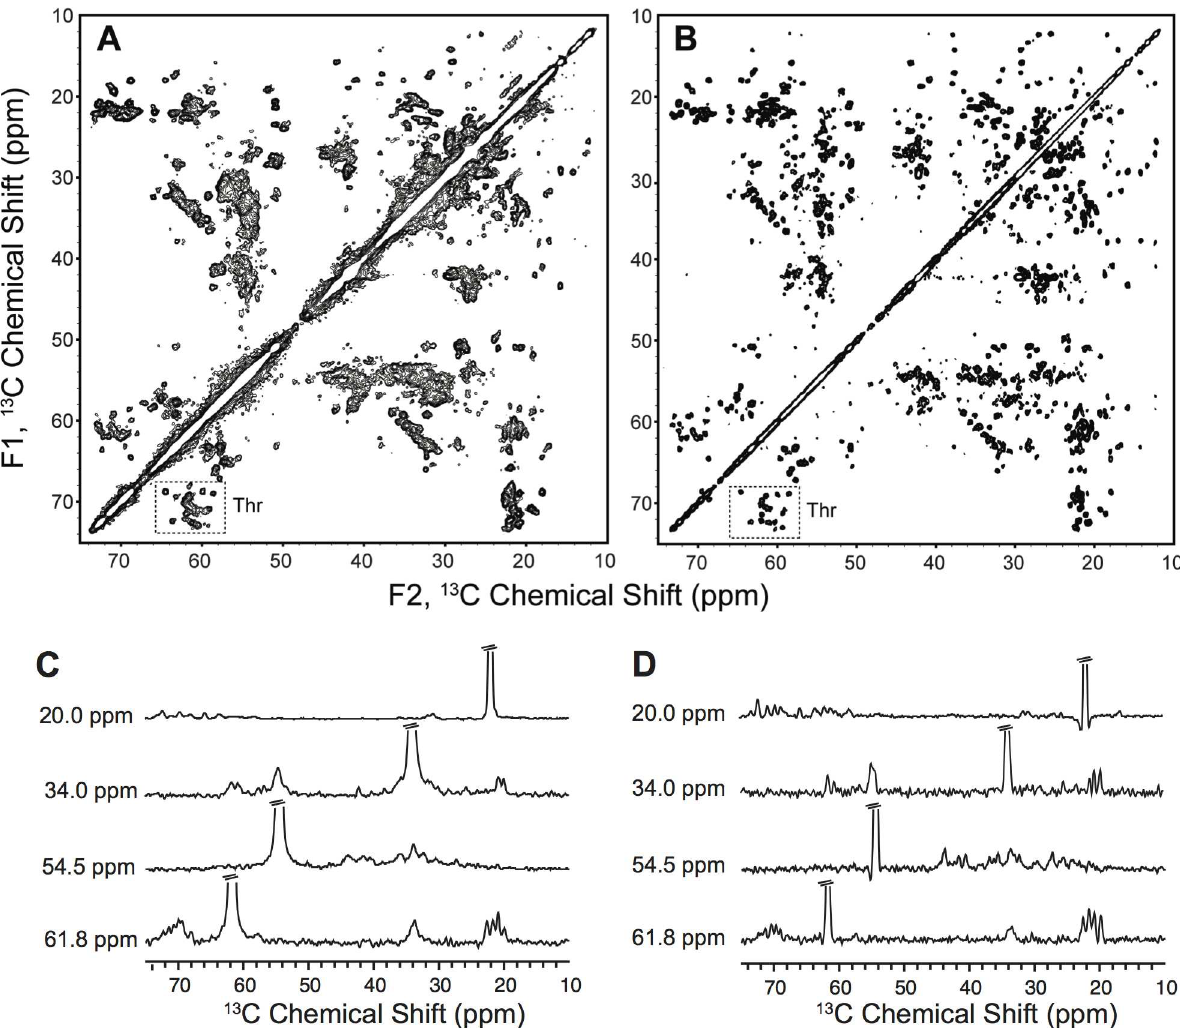
Fig 3. Solid-state 13 C- 13 C 2D correlation spectra of uniform 13 C, 15 N sTF. (A) 13 C- 13 C 2D correlationspectrum with 25 ms of DARR mixing of ~15 mg uniform 13 C, 15 N sTF precipitated with 15% PEG 3350 acquired at 750 MHz ( 1 H frequency) for 12 hours with a MAS rate of 12.5 kHz at a variable temperature set point of 0˚C. (B) 13 C- 13 C 2D correlationspectrum with 50 ms of DARR mixing of ~31 mg uniform 13 C, 15 N sTF precipitated with 1.8 M ammoniumsulfate and 5 mM Cu-EDTA acquired at 750 MHz ( 1 H frequency) for 24 hours with a MAS rate of 12.5 kHz at a variabletemperature set point of -5˚C. Both spectra were processedwith 20 Hz of Lorentzian-to-Gaussian line broadening in each dimension,sine bell apodization, and zero filled 8192 points in the direct (F1) dimensionand 4096 in the indirect (F2) dimension with contours drawn at 6 times the noise floor. (C) 13 C 1D slices extracted from the 13 C- 13 C 2D spectrum of PEG-precipitated sTF shown in A. The corresponding 13 C chemical shifts in the indirect dimensionare indicated. (D) 13 C 1D slices extracted from the 13 C- 13 C 2D spectrum of ammonium sulfate-precipitated sTF shown in B. The corresponding 13 C chemical shifts in the indirect dimension are